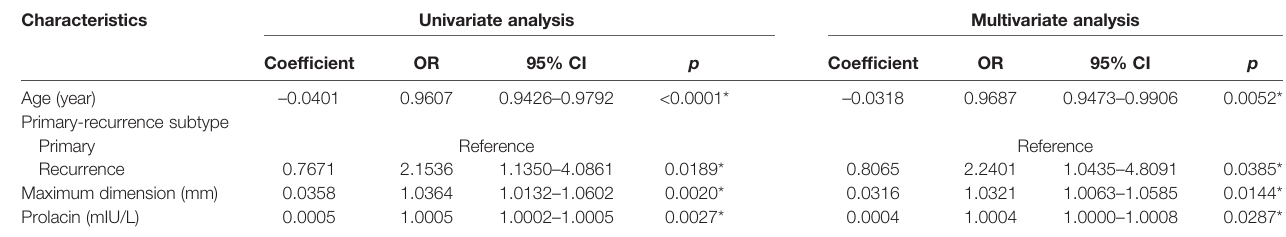
TABLE 2 | Univariate and multivariate logistic regression analysis for the fi nal model. Characteristics